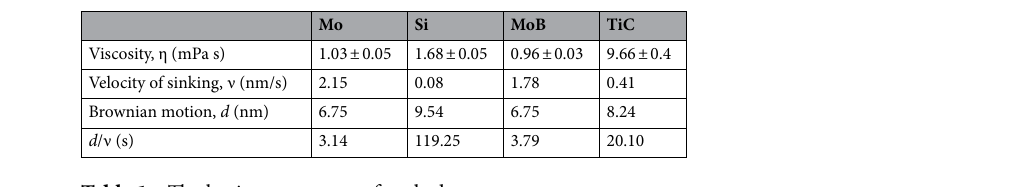
Table 1. The basic parameters of each slurry.